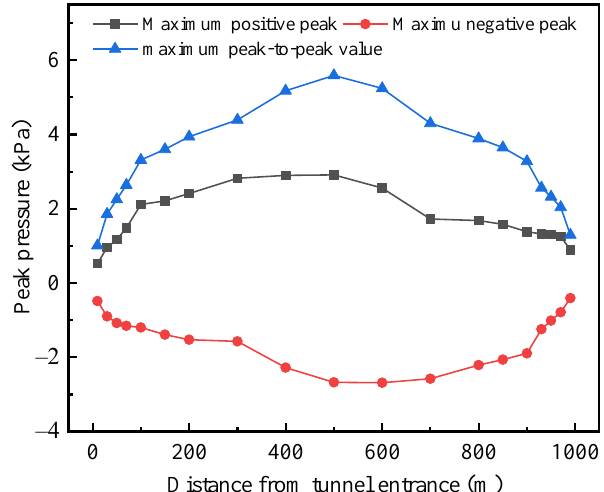
Figure 20. Distributions of maximum peak pressures along tunnel vault in Stage III. The relationships between the maximum peak pressure and the train speed of spe- cific monitoring points in Stage III are shown in Figure 21. The three types of maximum peak pressure values of the points near tunnel portals increase with increasing train speed. The three types of maximum peak pressure of tunnel middle section are more complex than those near tunnel portals. There are one or more turning points of these three types of maximum peak pressure of tunnel middle section.